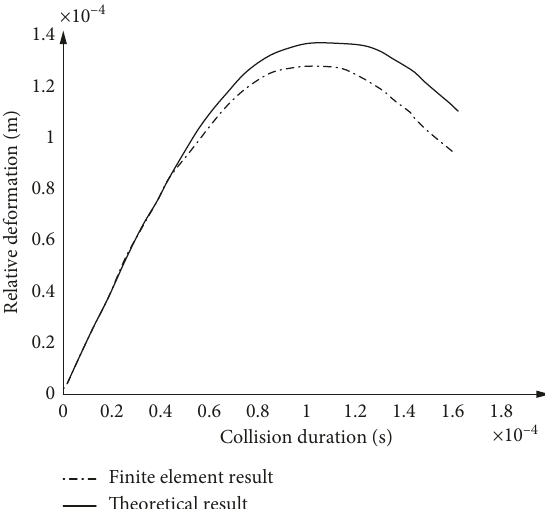
Figure 9: Curve of collision duration-relative deformation (tan- gential velocities of two balls are 0.1m/s and −